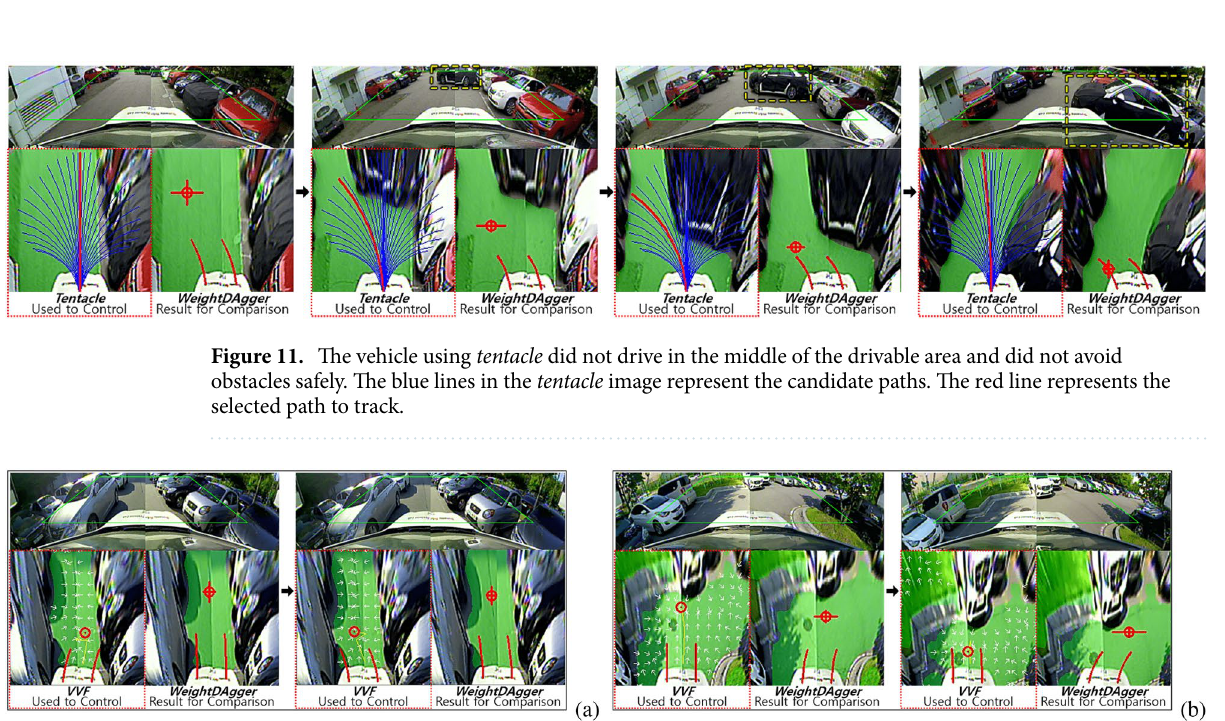
Figure 12. Problems with the VVF algorithm; The white arrows represent the field direction. ( a ) Oscillation in a narrow drivable area. ( b ) The vehicle could not enter the right side of the drivable area in advance at a right- angled corner. WeightDAgger did not encounter any problems in situations ( a ) and ( b